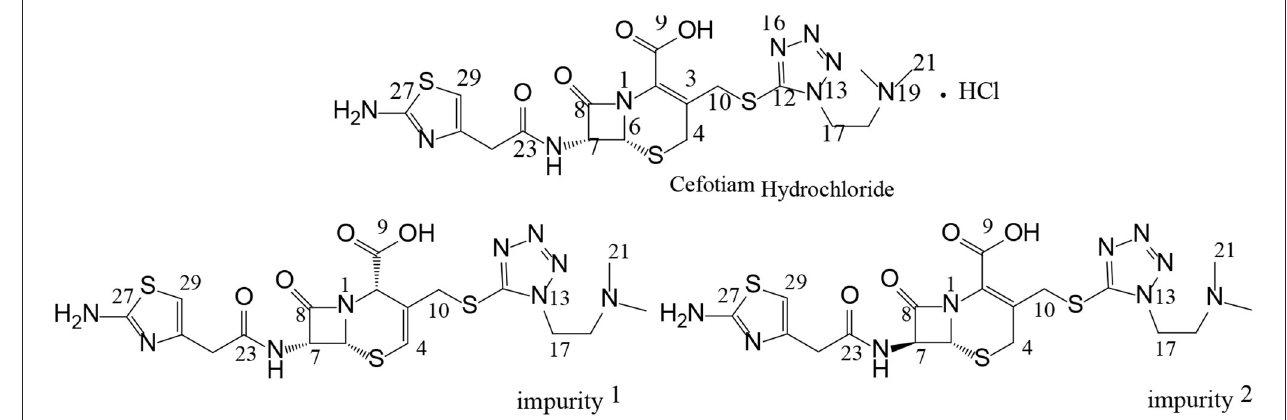
FIGURE 1 | Chemical structures of cefotiam, impurity 1, and impurity 2.